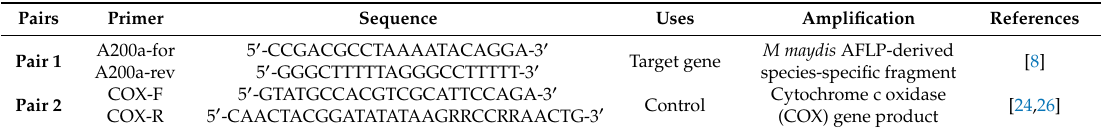
Table 2. Primers for Magnaporthiopsis maydis qPCR detection